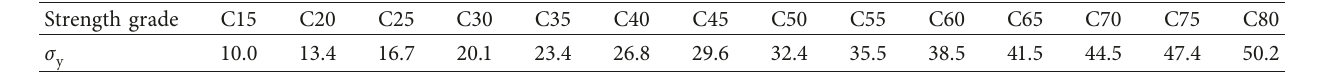
Table 6: Standard value of axial concrete compressive strength (MPa) [25].